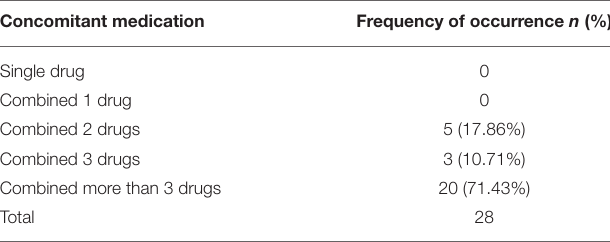
TABLE 2 | The number of annual reports and clinical characteristics in Pantoprazole reports about hepatic